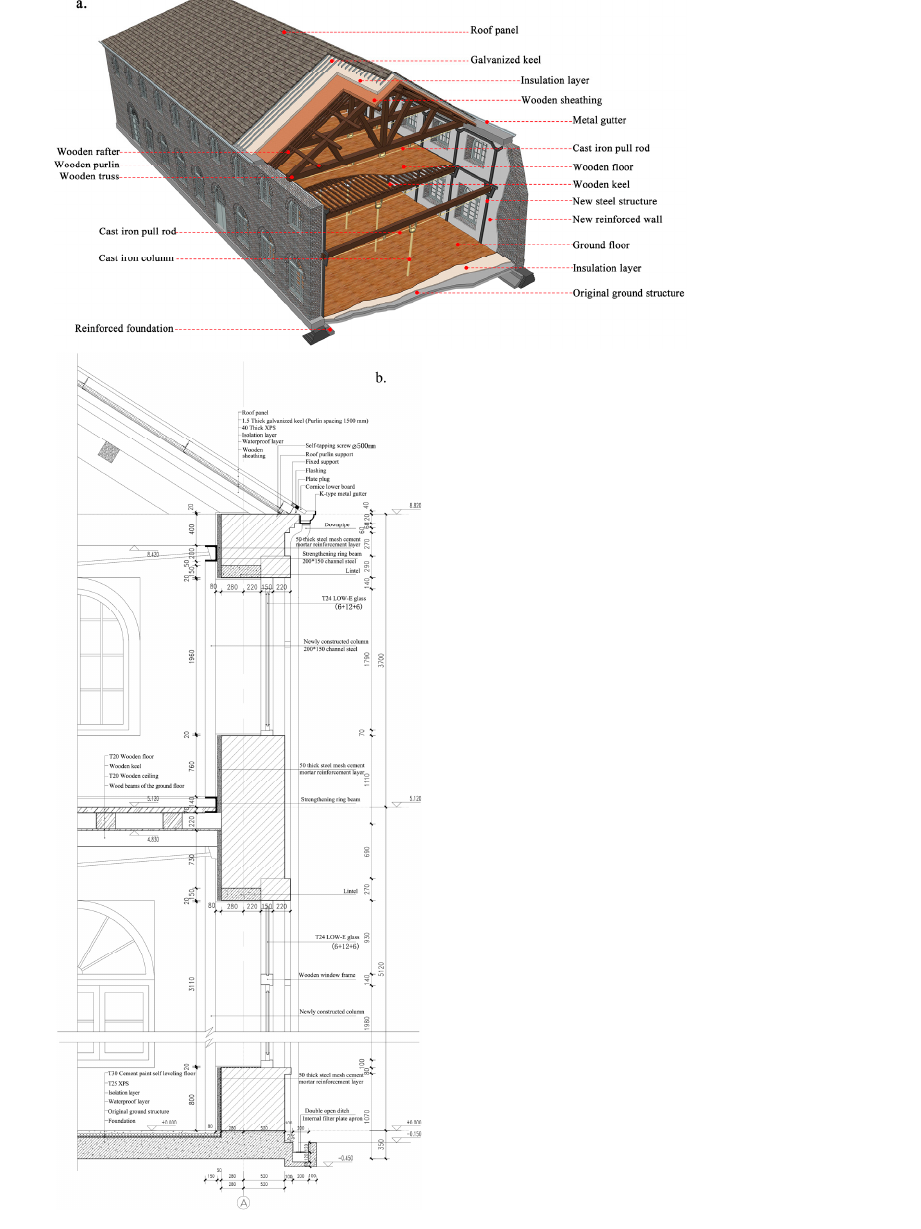
Figure 15. Spatial expression ( a ) and specific technique diagram ( b ) of restoration. Pictures by X.X.